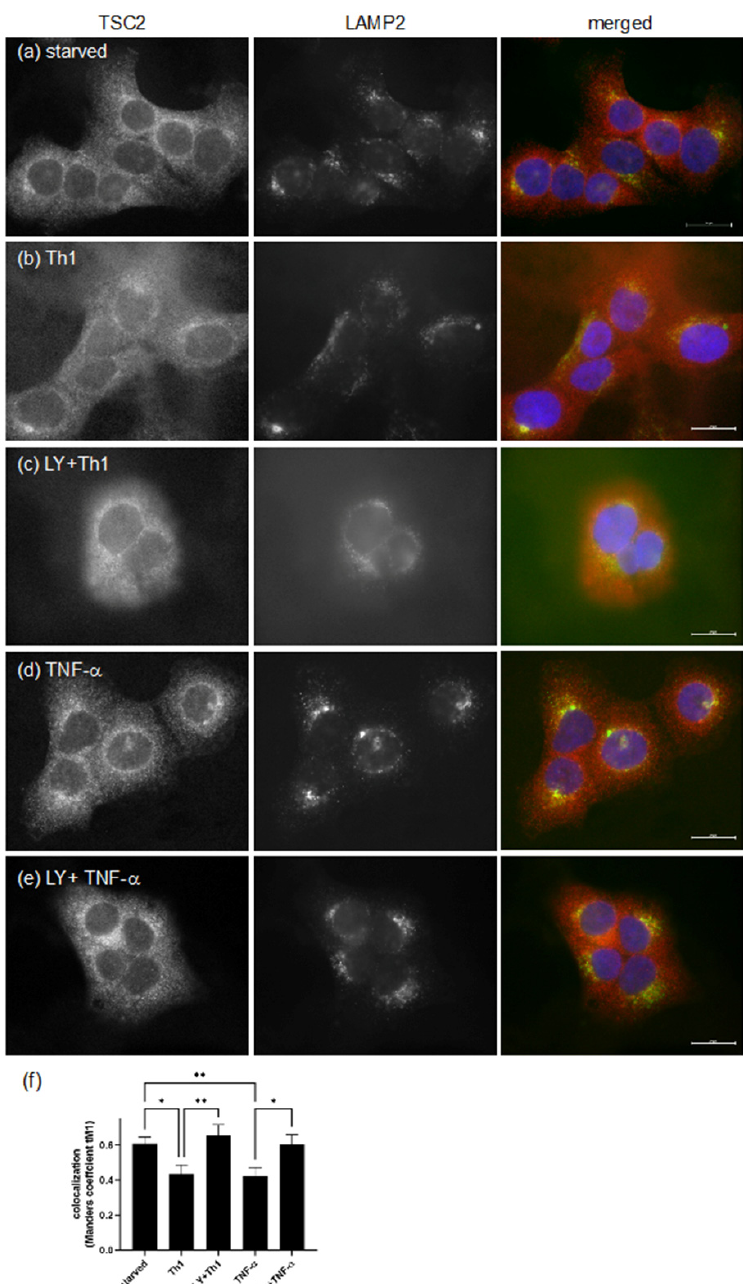
Figure 4. HaCaT cells were serum-starved ( a ) and treated with a cytokine cocktail consisting of IL-1 β , IL-17A and TNF- α (20 ng/mL each) ( b , c ) or TNF- α alone (20 ng/mL) ( d , e ) for 30 min. If indicated, cells were pre-treated with 50 µ M LY294002 (LY) for 30 min ( c , e ). Cells were fixed and stained for TSC2 (red) and LAMP2 (green), and nuclei were visualized with DAPI (blue). Monochrome images of the red and green channel as well as merged images are shown. Bars indicate 20 µ m. ( f ) Colocalization analysis of TSC2 and LAMP2 (thresholded Manders coefficient) is shown as mean ± SEM of 8–14 images from three individual experiments. Statistical significance was assessed with one-way ANOVA and Fisher’s LSD test (* p < 0.05, ** p < 0.01).